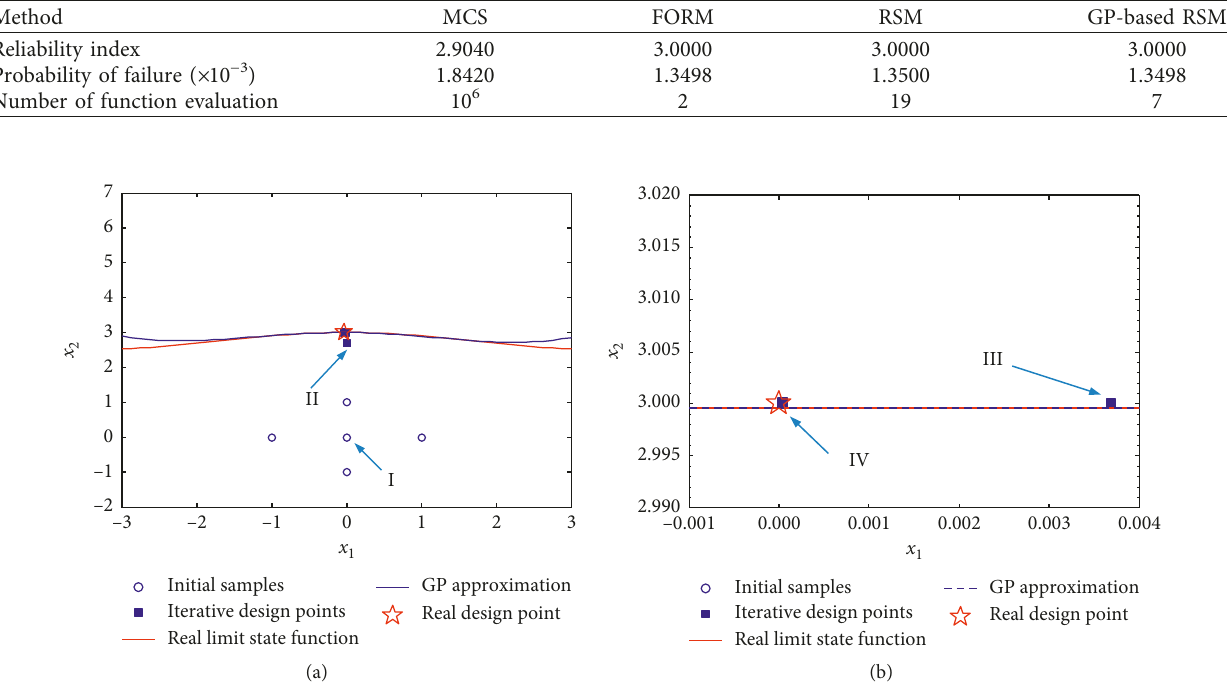
Table 3: Results of Example 1 using different methods.